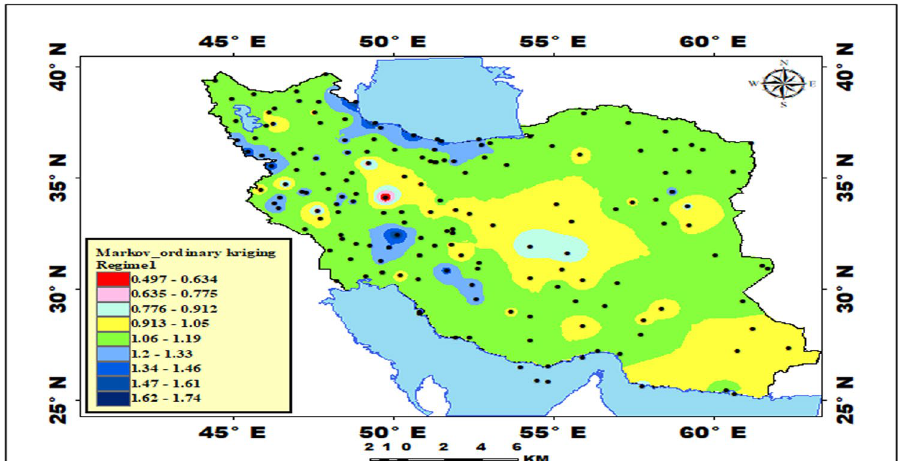
Fig. 11 The probability of the daily rainfall reoccurrence based on the regime1 model